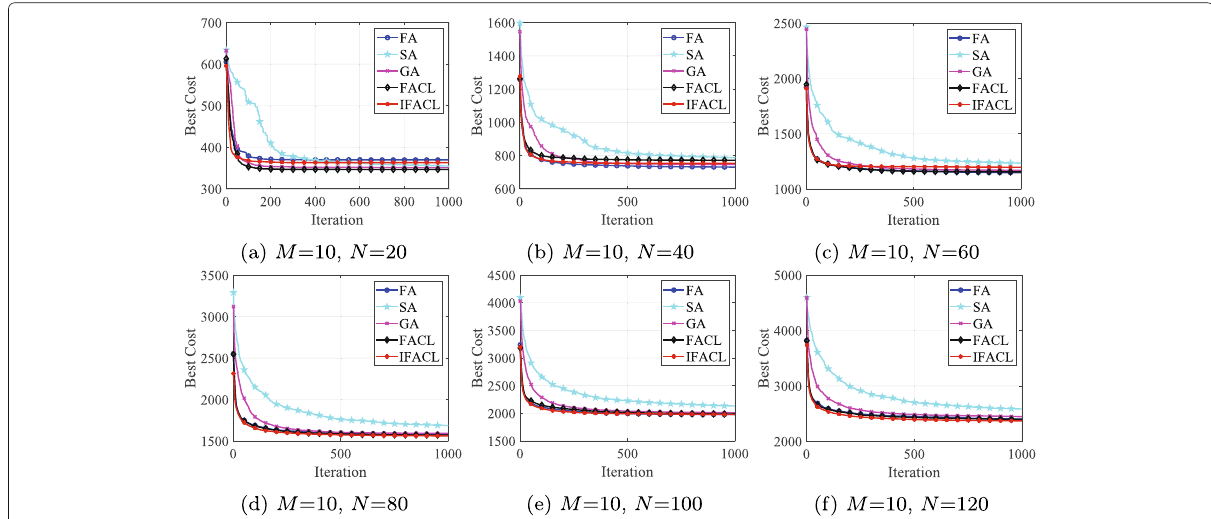
Fig. 7 Average convergence curve for each algorithm on PDominant instances of Dataset1 when the number of machines M